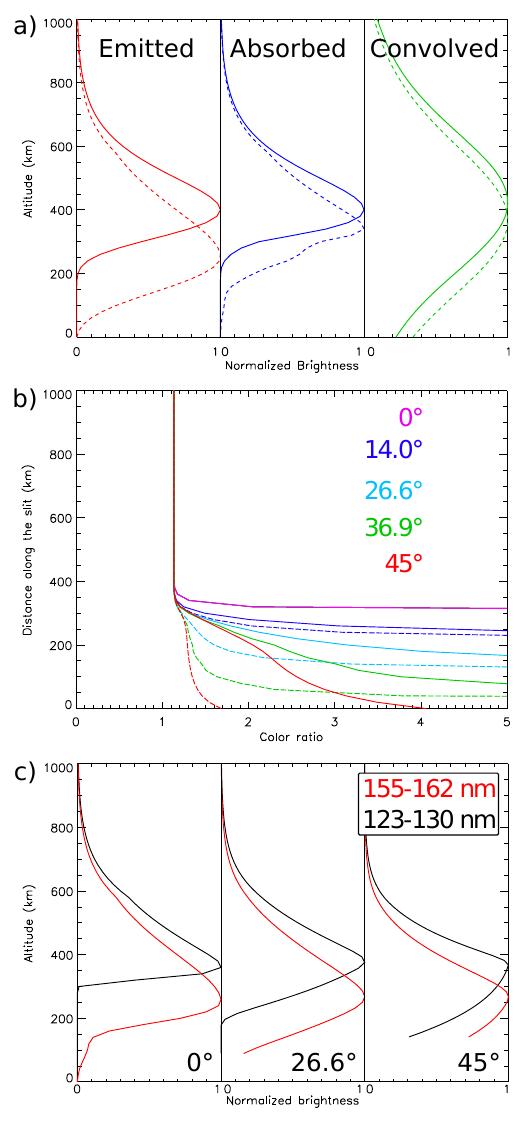
Figure 4. Panel (a) shows the UV H 2 emission vertical profile, the apparent profile as seen by ACS/SBC with the F125LP filter above the limb, and the convolved apparent profiles for two test profiles. The first one peaks at 400km (solid line) and the second one peaks at 250km (dashed line). Panel (b) shows the apparent color ratios for various angles between the 0.5arcsec slit and the normal to the limb for two simulated vertical profiles peaking at 400km (solid lines) and 250km (dashed lines). Panel (c) shows the apparent pro- files in the 155–162nm range (red) and 123–130nm range (black) for an emissions profile peaking 250km above the